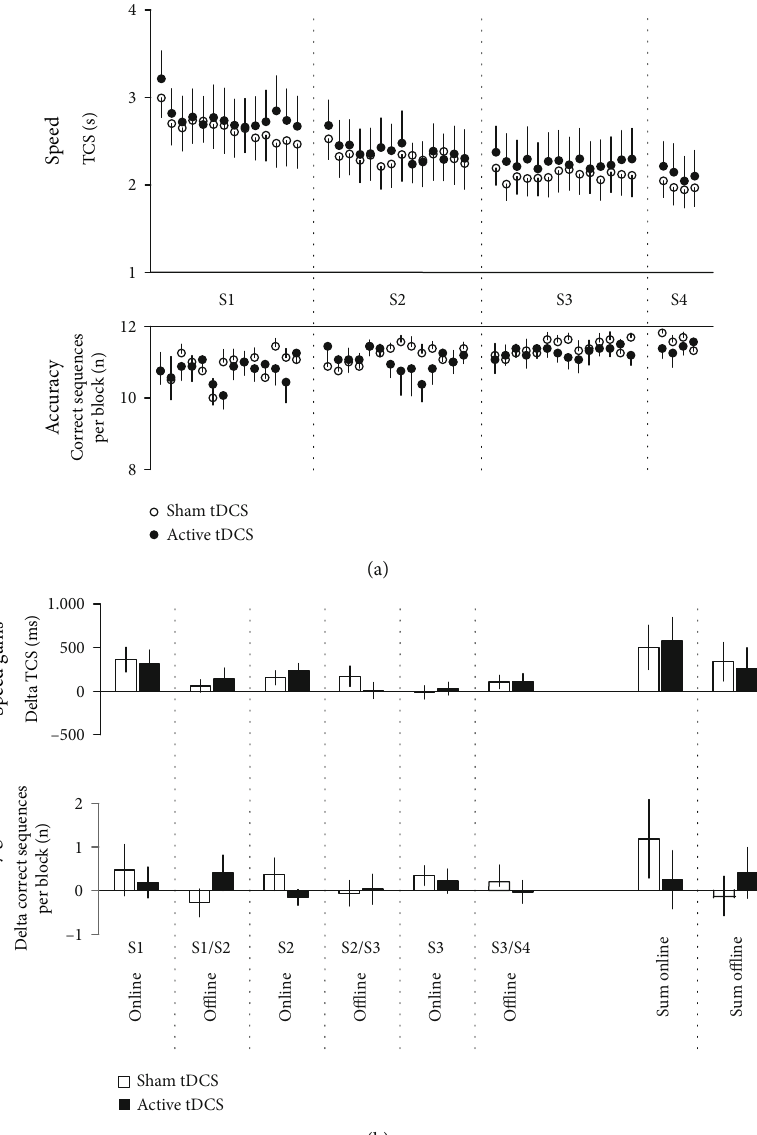
Figure 2: Speed and accuracy of task performance. (a) Speed (mean time to perform a correct sequence per block, TCS) and accuracy (number of correct sequences per block) of task performance across blocks of training in session 1 (S1) on day 1, session 2 (S2) on day 3, session 3 (S3) on day 5, and session 4 (S4) on day 8 of the posttraining sham and active tDCS experiments. Vertical bars represent the standard error of the mean (SEM). (b) Online and o ffl ine task performance changes. Online speed and accuracy performance changes during training sessions (S1, S2, and S3) were calculated as the di ff erence of performance between the beginning of a training session ( fi rst two blocks) and the end of a training session (last two blocks) such that positive values indicate improvement of speed or accuracy performance across the training session. O ffl ine performance changes between training sessions S1 and S2, S2 and S3, and S3 and S4 were assessed between the last two blocks of the previous training session and the fi rst two blocks of the next training session such that positive values indicate o ffl ine speed and accuracy improvement of performance relative to the performance at the end of the previous session. Overall online and o ffl ine learning (sum online, sum o ffl ine) was calculated as the sum score of the three individual online (during session) and o ffl ine (between sessions) measures. Bars represent